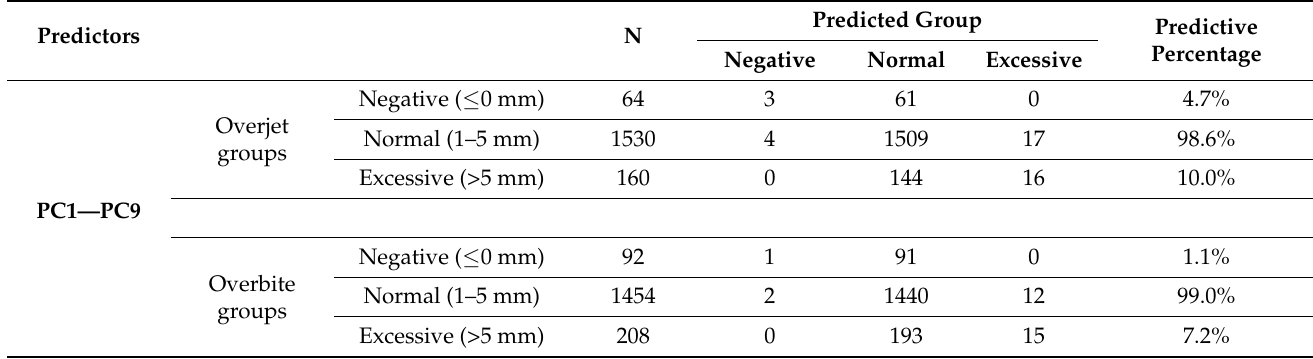
Table 2. Discriminant analysis of the predictive value of profile shape on severity of overjet and overbite. Predicted Group Predictive Predictors N PercentageNegative Normal